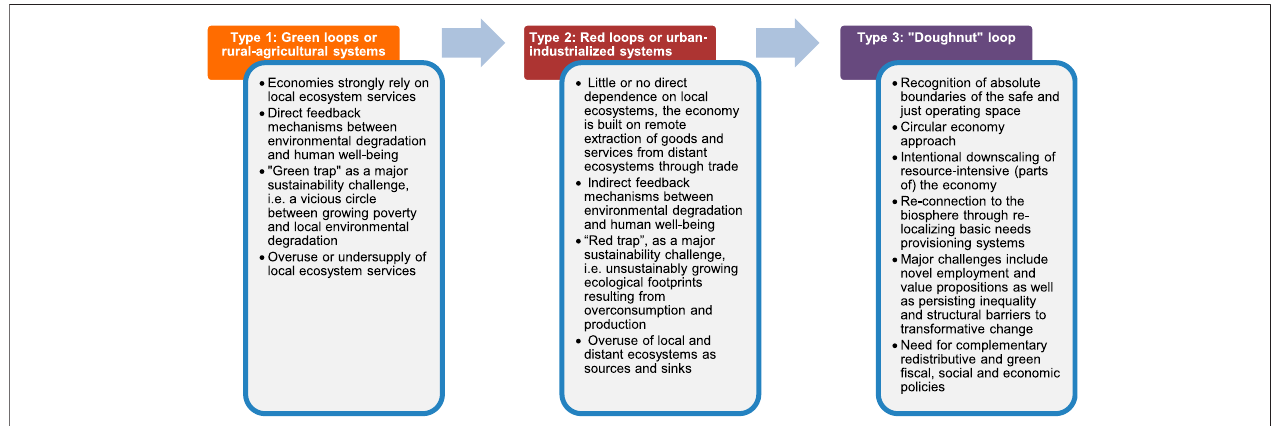
FIGURE 5 | The expanded loop transition model. Adopted from Cumming et al. (2014) and Raworth (2017).